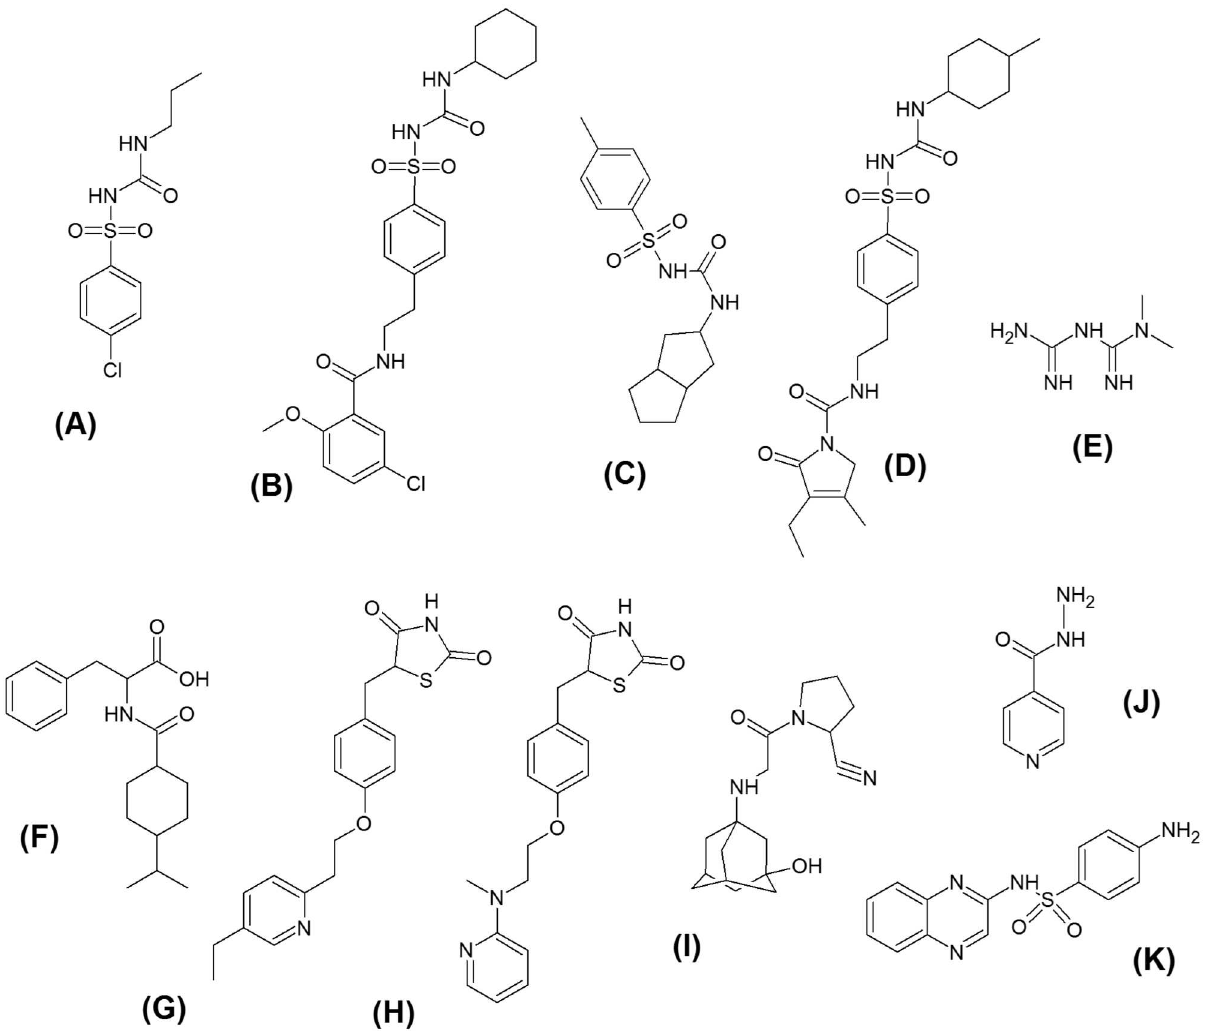
Fig 1. Chemical structuresof (A) chlorpropamide, (B) glibenclamide, (C) gliclazide, (D) glimepiride, (E) metformin, (F) nateglinide, (G) pioglitazone, (H) rosiglitazone, (I) isoniazid, IS, and (K) sulfaquinoxaline,